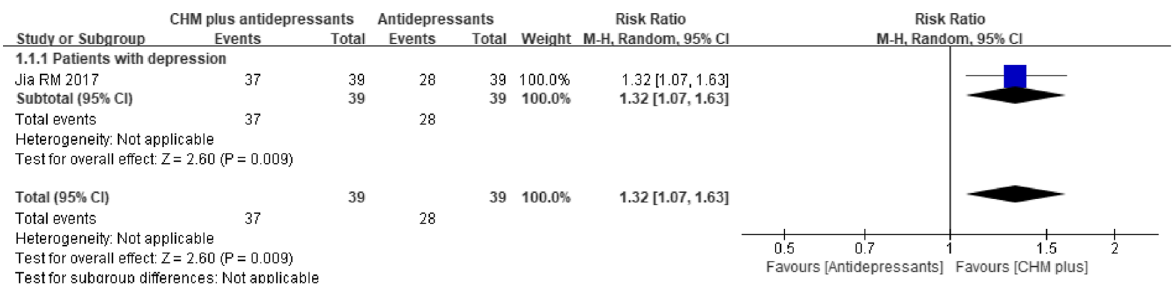
Fig. 9 Forest plot of the depression treatment response rate for CHM plus antidepressants versus antidepressants alone